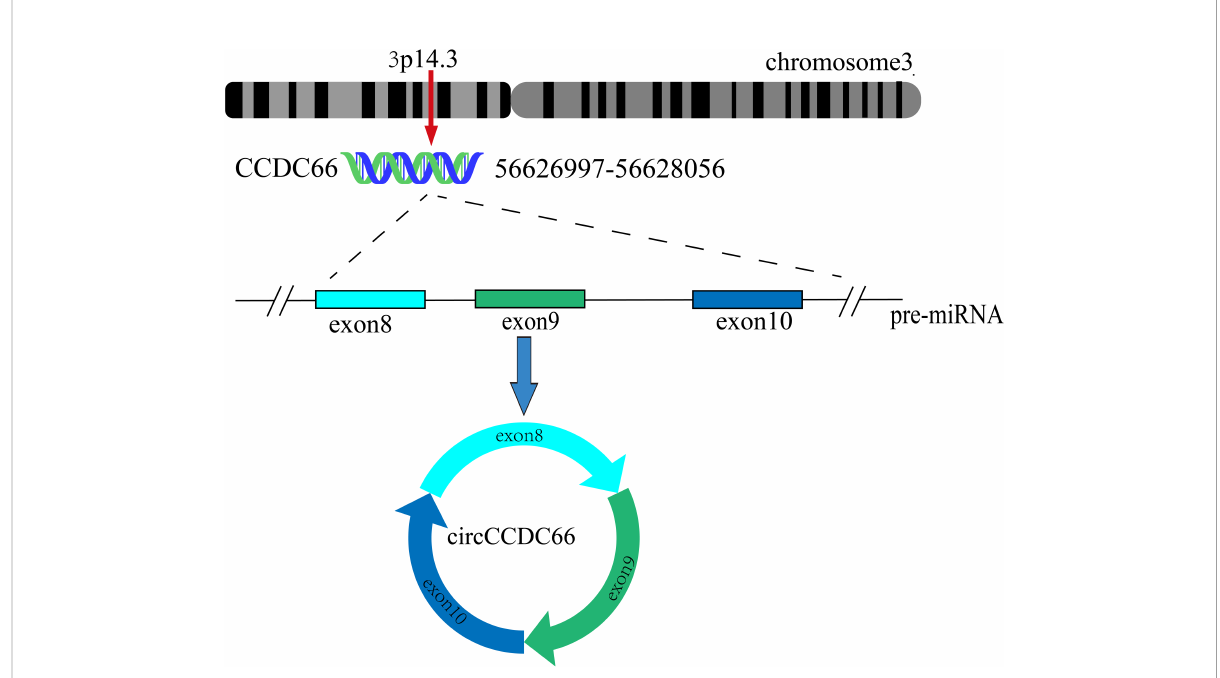
FIGURE 2 Schematic representation of the formation of circCCDC66. Exons 8-10 of CCDC66 located on chromosome 3 produce a 468-nucleotide